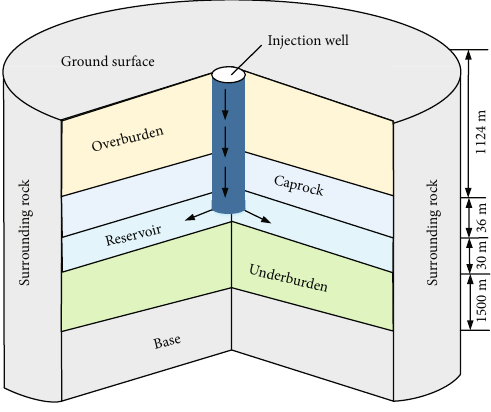
Figure 5: The 3D conceptual model of S trap (note: this is only a picture of the conceptual model, it is di ff erent from the actual analysis model ’ s